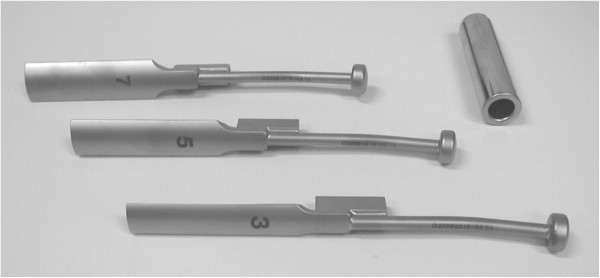
Impaction grafting system (IGS). Special impactors in sizes 3, 5 and 7 mm and extension sleeve (Peter Brehm GmbH, Weisendorf, Germany) to be used for the proximal metaphyseal allograft augmentation, using the press fit impaction technique.